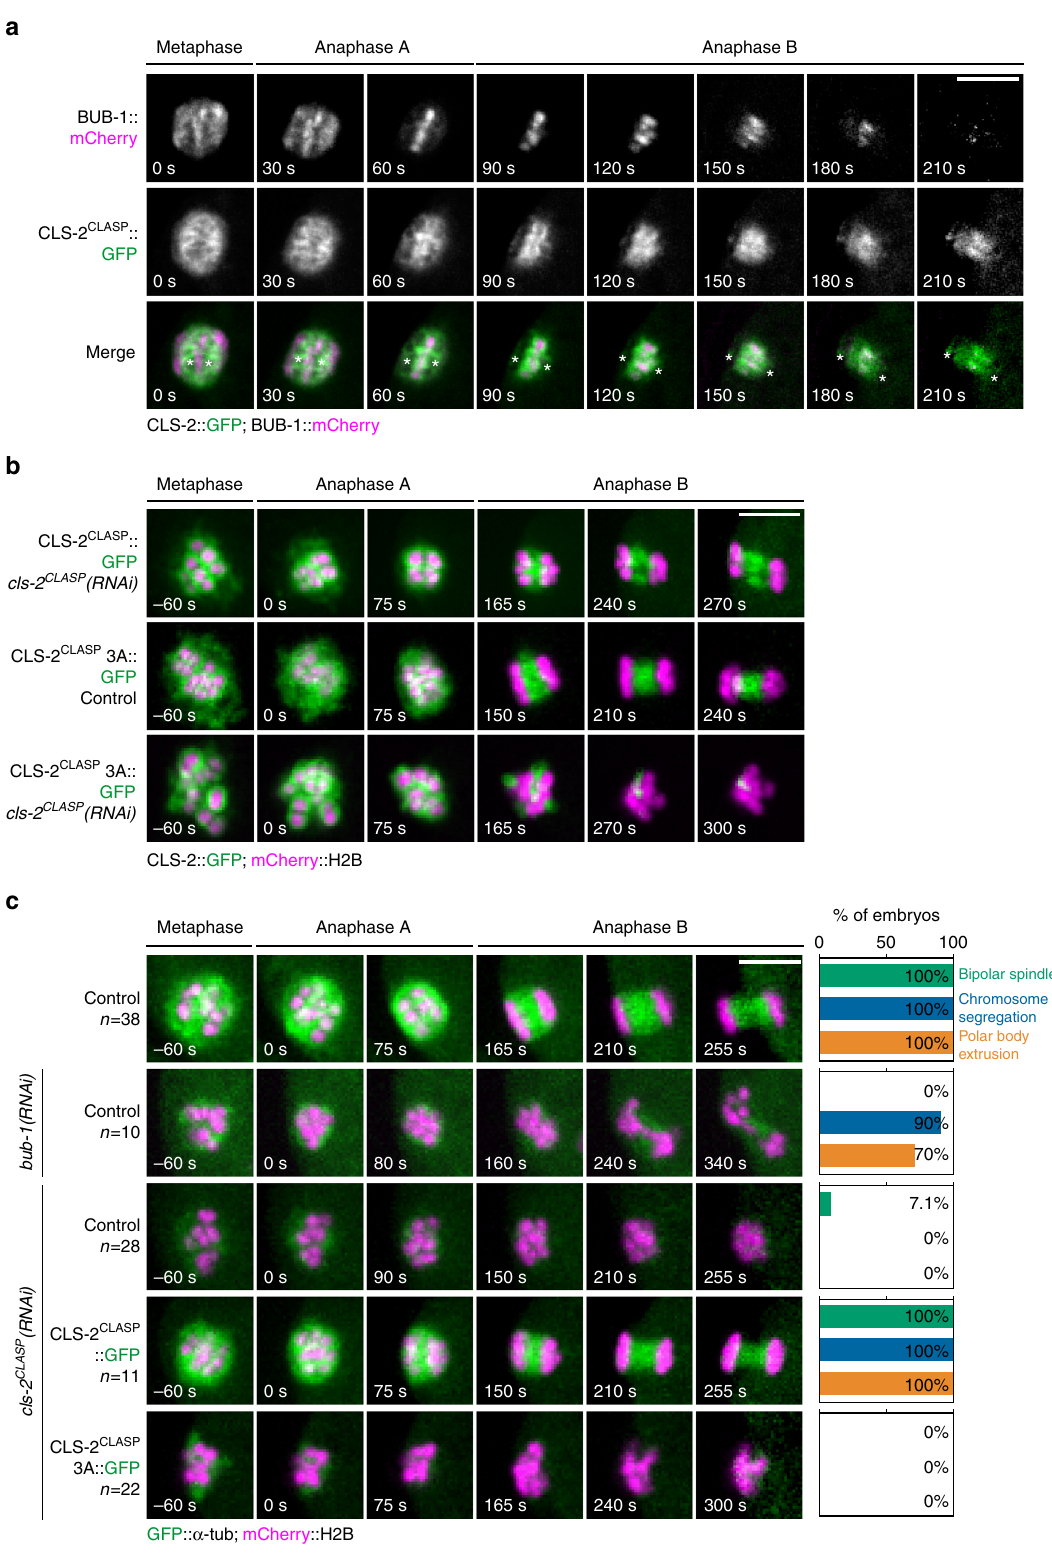
Fig. 5 CLS-2 CLASP microtubule polymerase activity is required for meiotic chromosome segregation. a BUB-1::mCherry (top row), CLS-2 CLASP ::GFP (middle row), and merged (bottom row) localization during anaphase I. Asterisks denote the approximate centroid locations of the segregating chromosome masses. b GFP-tagged CLS-2 CLASP and CLS-2 CLASP 3A localization during anaphase I in the indicated conditions. c Still images from live imaging of fertilized oocytes expressing GFP-tagged α -tubulin and mCherry-tagged histone H2B in the indicated conditions. Quanti fi cations of the percentage of observed bipolar spindles, chromosome segregation events, and polar body extrusion in meiosis I is shown on the right of each still sequence. Timings are indicated in the bottom left corner of each frame. Scale bars, 5 µ